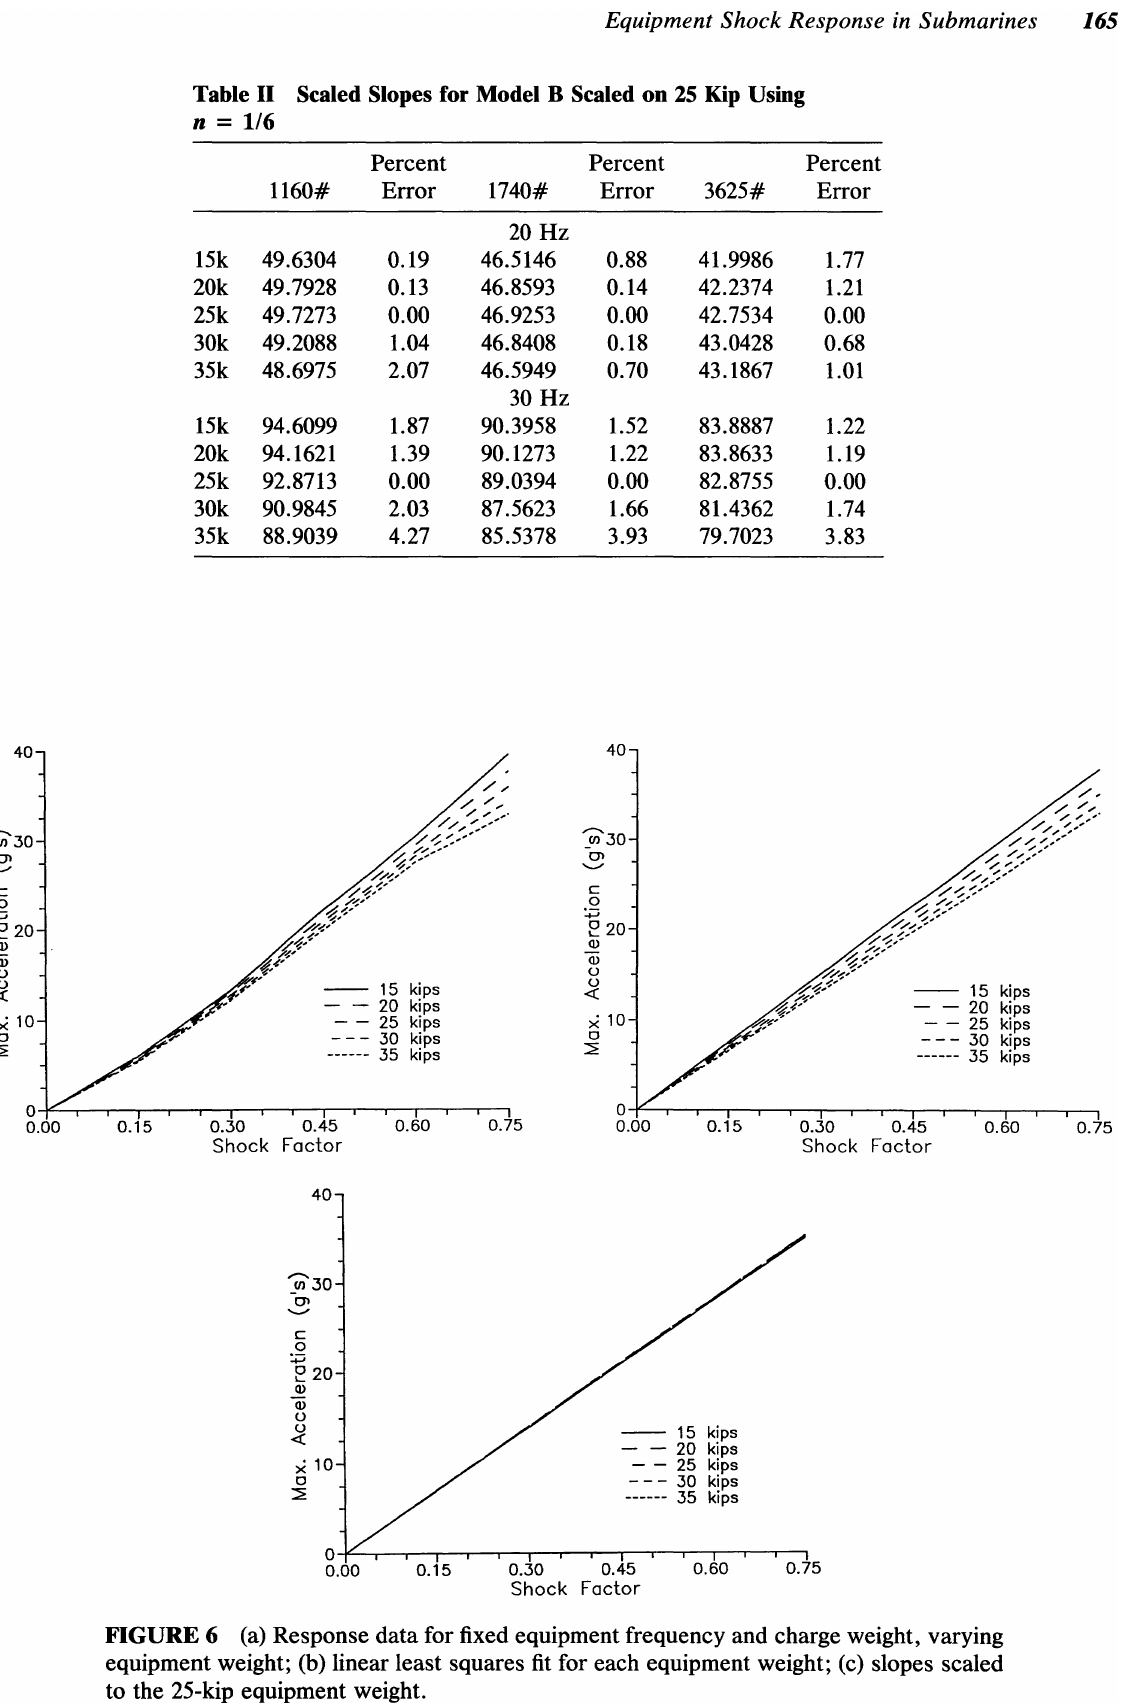
Table II Scaled Slopes for Model B Scaled on 25 Kip Using